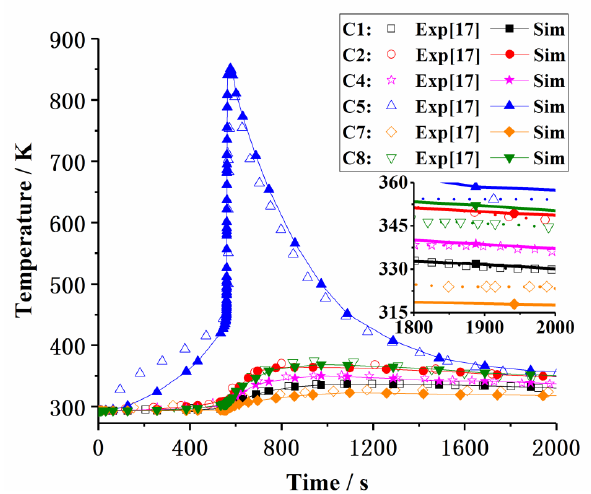
Figure 2. Verification of the correctness of the simulation results via experimentation.